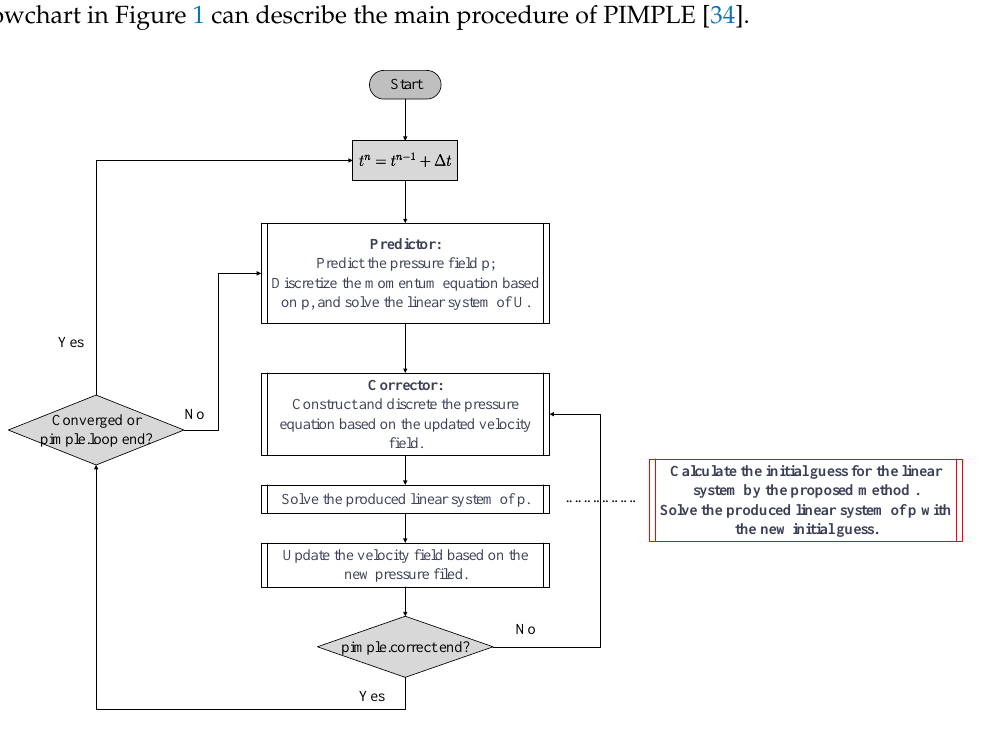
Figure 1. The flowchart of PIMPLE algorithm and the difference using the proposed